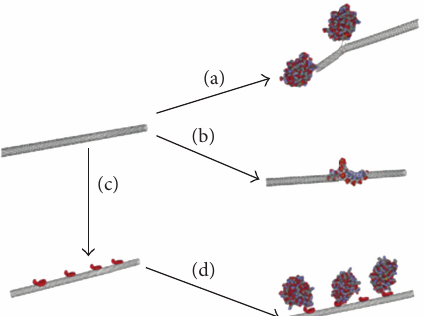
F 3: e three main approaches for modifying carbon nan- otubes with biomolecules: the covalent approach (step a), noncova- lent approach (step b), and hybrid approach where a small